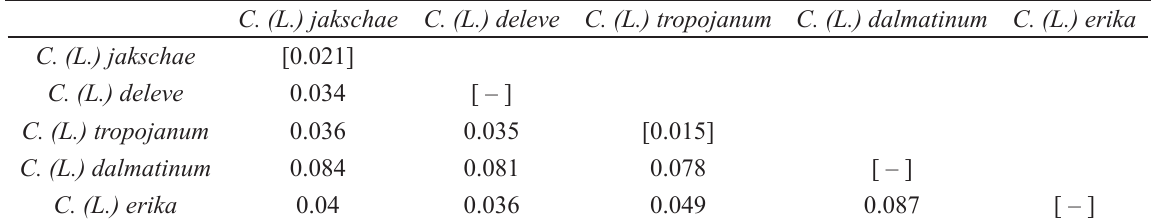
Table 2. Estimates of evolution divergence between populations and species in Cochlostoma (Lovcenia) Zallot et al. , 2015. Mean uncorrected COI p-distances are shown between species (in the lower half of the matrix) and between conspecific population (in the matrix